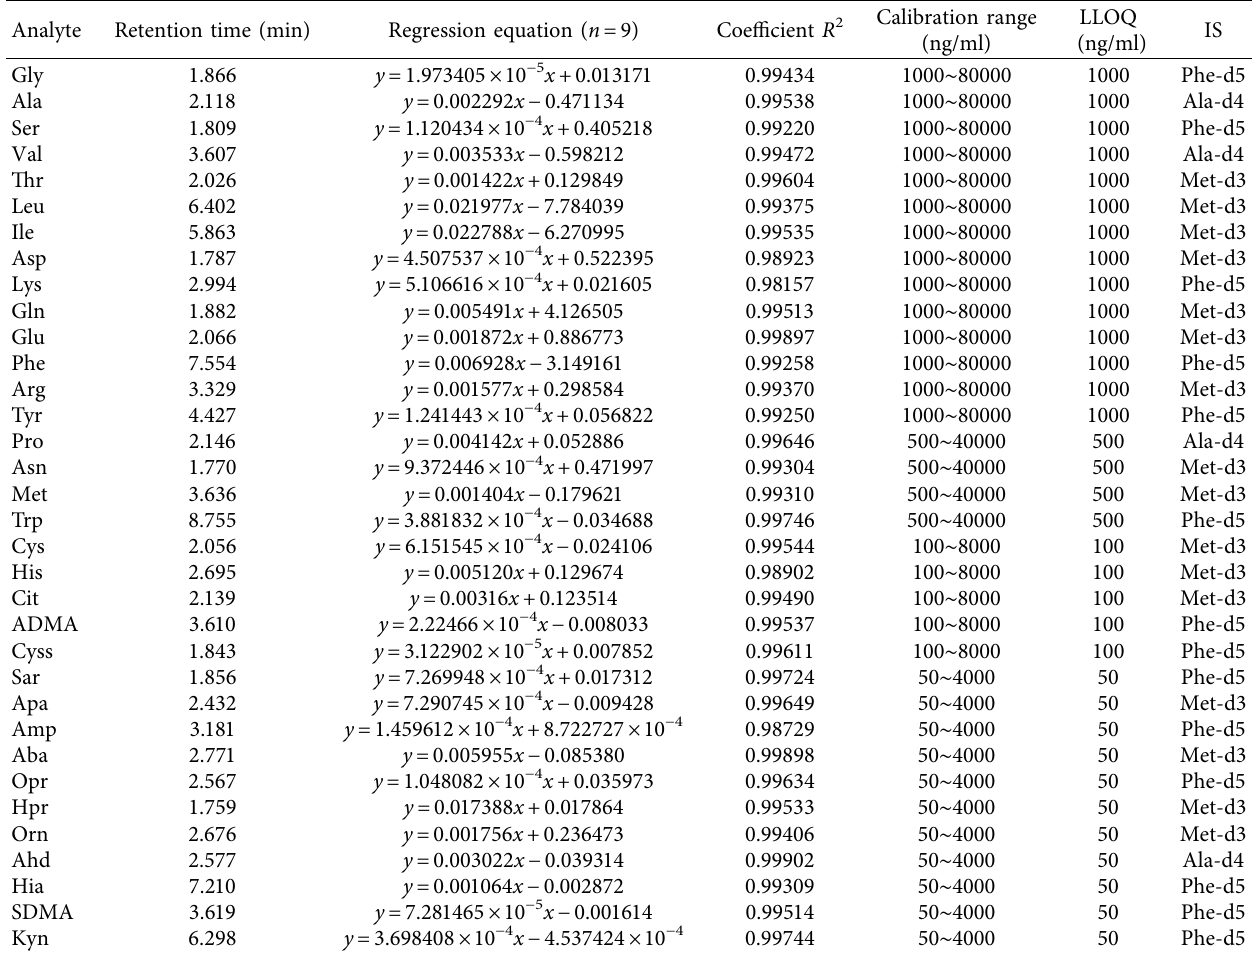
Table 4: The retention times, regression equations, coefficients, calibration ranges, and LLOQ for 34 amino acids and each corresponding IS. Analyte Retention time